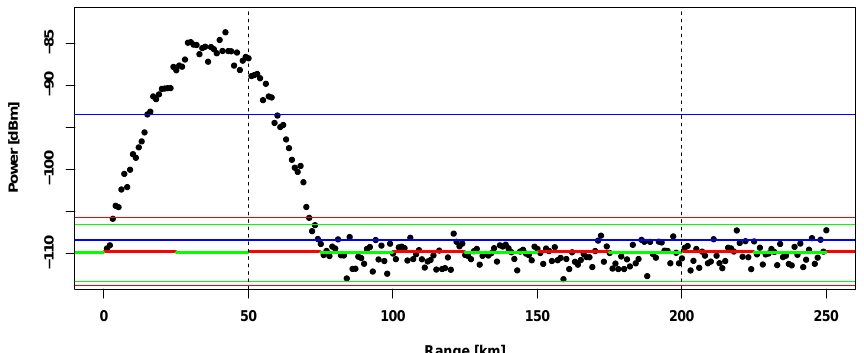
Figure 4. Statistical estimators in simulated rain with noise. The thick lines give three estimators of the centre point: mean from 50km distance (blue), median from 50km distance (red), mean from 200km distance (green). The thin lines of the respective colours indicate the filtering windows. The second blue thin line at − 123dBm is not shown. The window width for the mean estimator is 3 times the standard deviation and for the median estimator is 3 times the median absolute deviation scaled by 1.4280 so that it agrees with the standard deviation of the underlying normal distribution. The two range limits are indicated by vertical dashed lines.